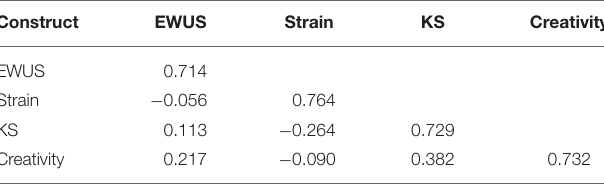
TABLE 4 | Construct correlation matrix and the square root of AVE in the diagonal.